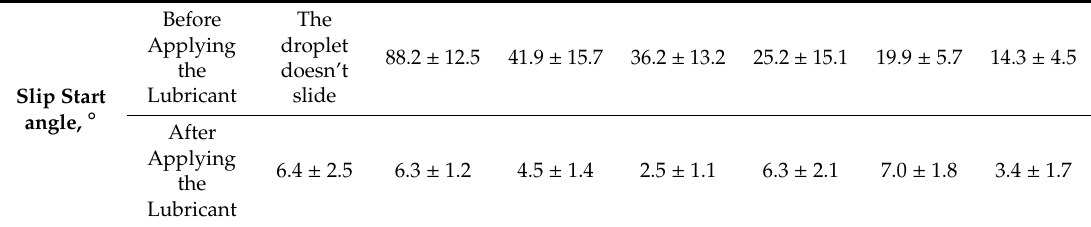
Table4. Slipstartangleofmechanicallydamagedsamplesbeforeandafterapplyingtheperfluorodecalin as a Table 4. Slip start angle of mechanically damaged samples before and after applying the perfluorodecalin as a lubricant.